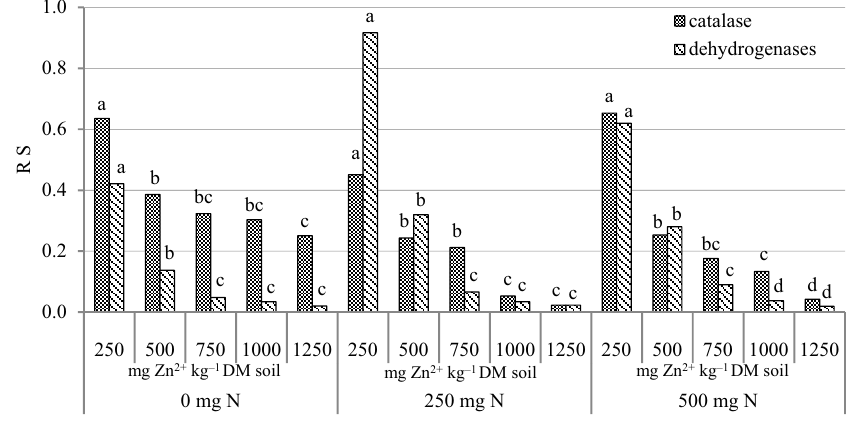
Fig. 3. Resistance index (RS) of oxidoreductases in the soil contaminated with zinc after two weeks of